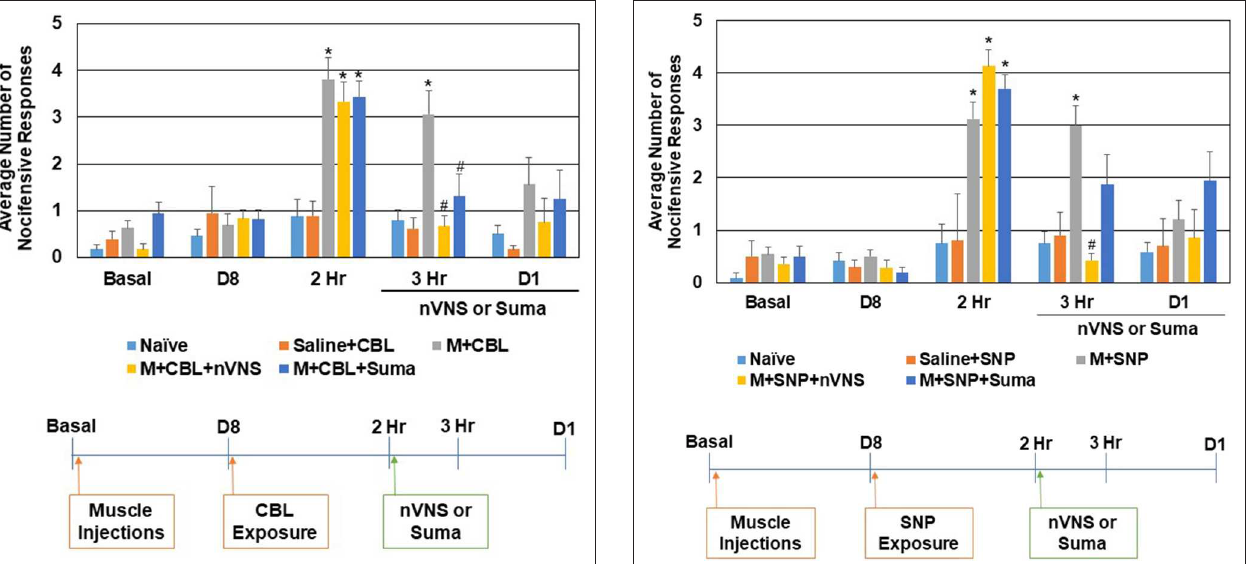
FIGURE 2 | nVNS and sumatriptan inhibit trigeminal nociception mediated by nitric oxide in sensitized animals. The average nocifensive head withdrawal response ± SEM of 5 applications to each side to mechanical stimuli are reported. Some animals were left untreated (Naïve), some were injected with saline in the trapezius (Saline) and exposed to the nitric oxide donor sodium nitroprusside (SNP), while others were injected with complete Freund’s adjuvant 8 days prior to exposure to SNP (M + SNP) and nociceptive responses determined at 2h, 3h, and 1 day post SNP exposure. Some of the M + SNP animals were treated with nVNS or sumatriptan and nociception measured 1h and 1 day post treatment. * P < 0.05 when compared to Naïve while # P < 0.05 compared to M +